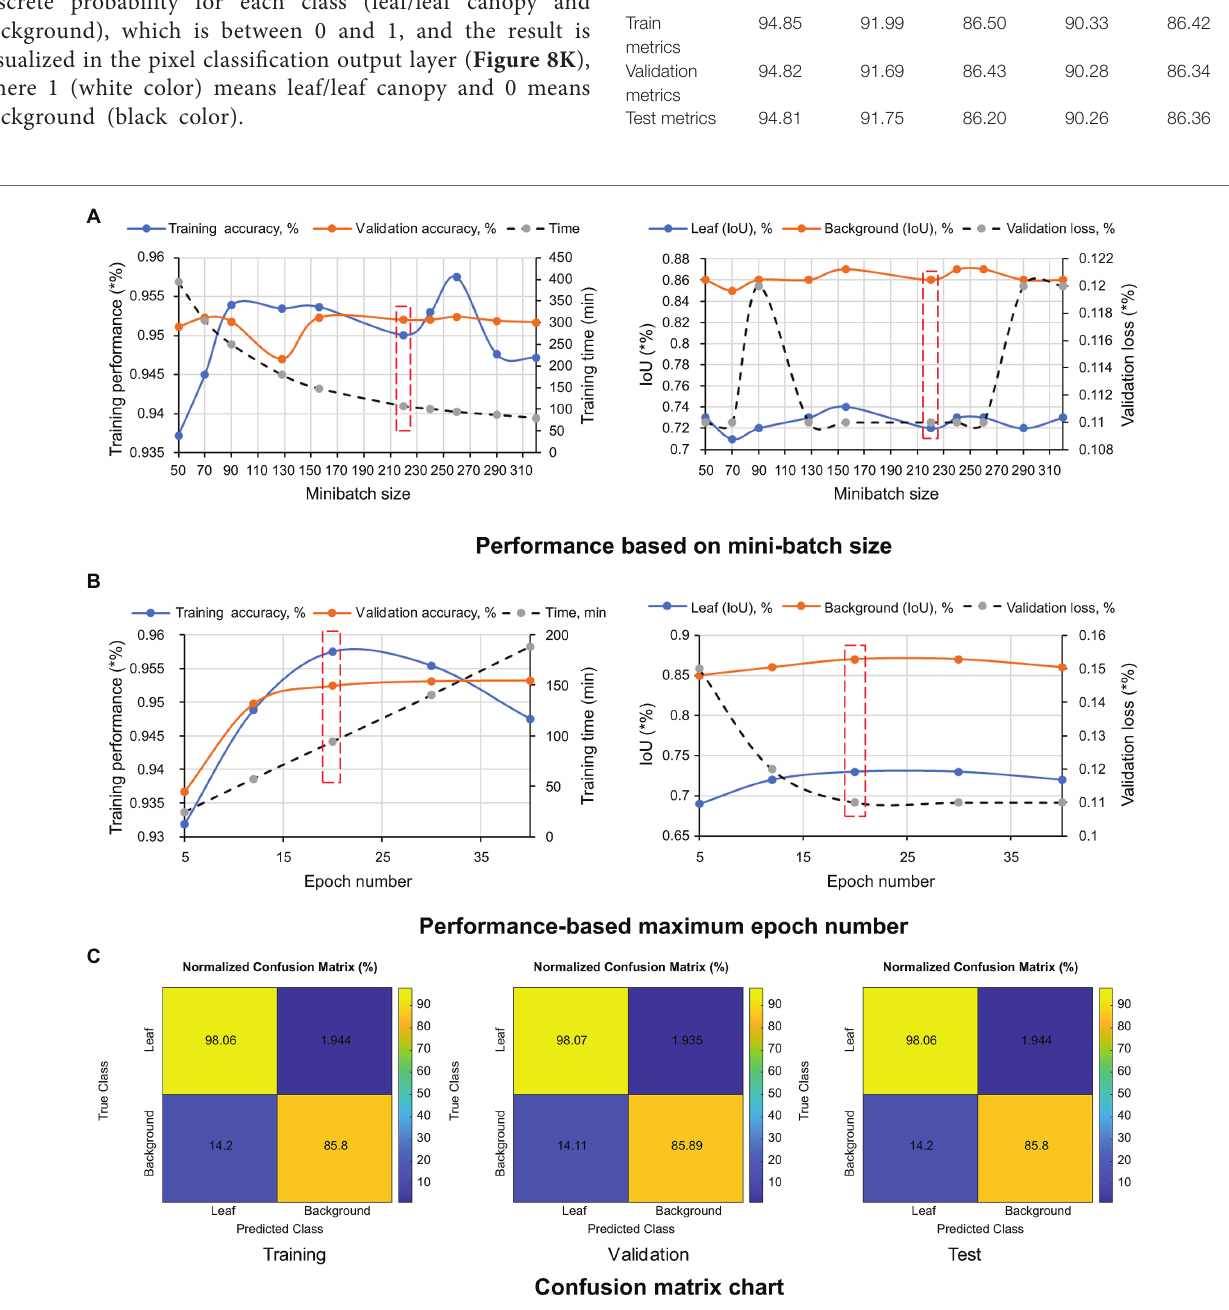
FIGURE 10 | Performance metrics of TheLNet270v1. (A) Performance based on mini-batch size. (B) Performance-based maximum epoch number. (C) Confusion matrix chart.